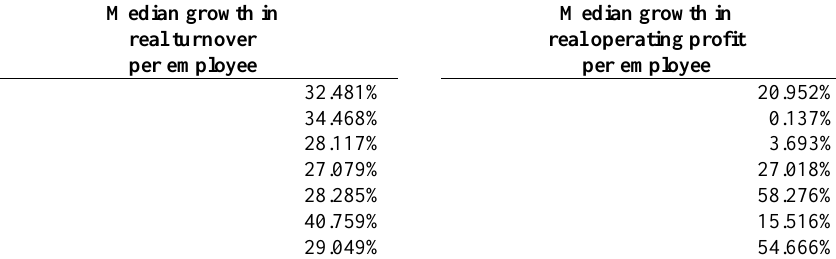
Table 3: Test for